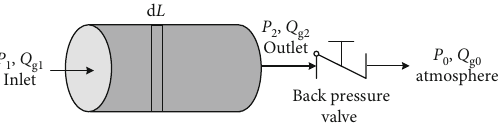
Figure 2: Schematic representation of fl ow